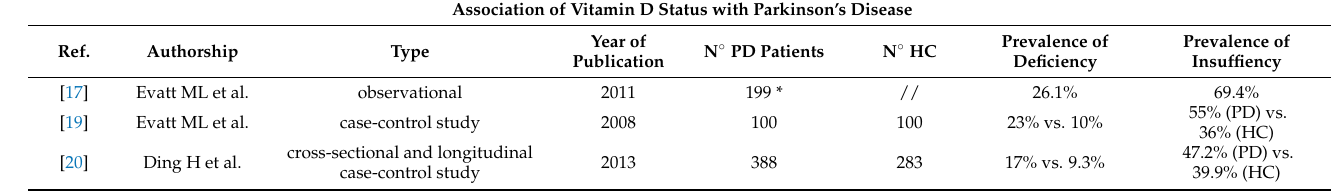
Table 1. Most relevant studies showing association of Vitamin D status with Parkinson’s Disease (PD). Legend of abbreviations: PD (Parkinson’s Disease); HC (Healthy Controls). * Patients from DATATOP: The Deprenyl and Tocopherol Antioxidative Therapy of Parkinsonism (DATATOP) cohort is a well-characterized cohort of subjects with early, nondisabling PD.